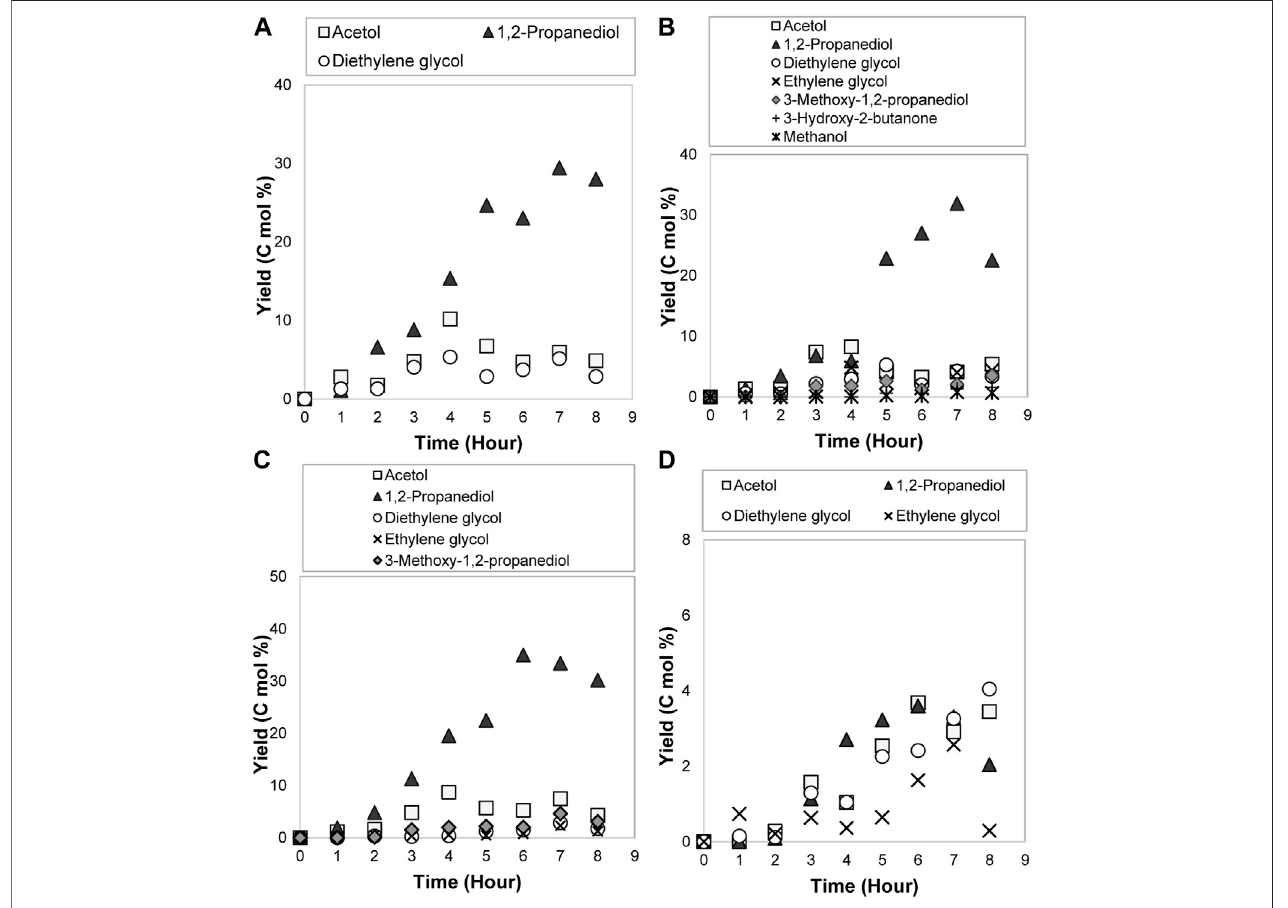
FIGURE 8 | Products distribution with glycerol initial concentration of (A) 0.3 mol/L, (B) 1.65 mol/L (C) 3.0 mol/L and (D) 4.35 mol/L during the electrocatalytic reduction reaction at 353 K and 0.14 A/cm 2 .